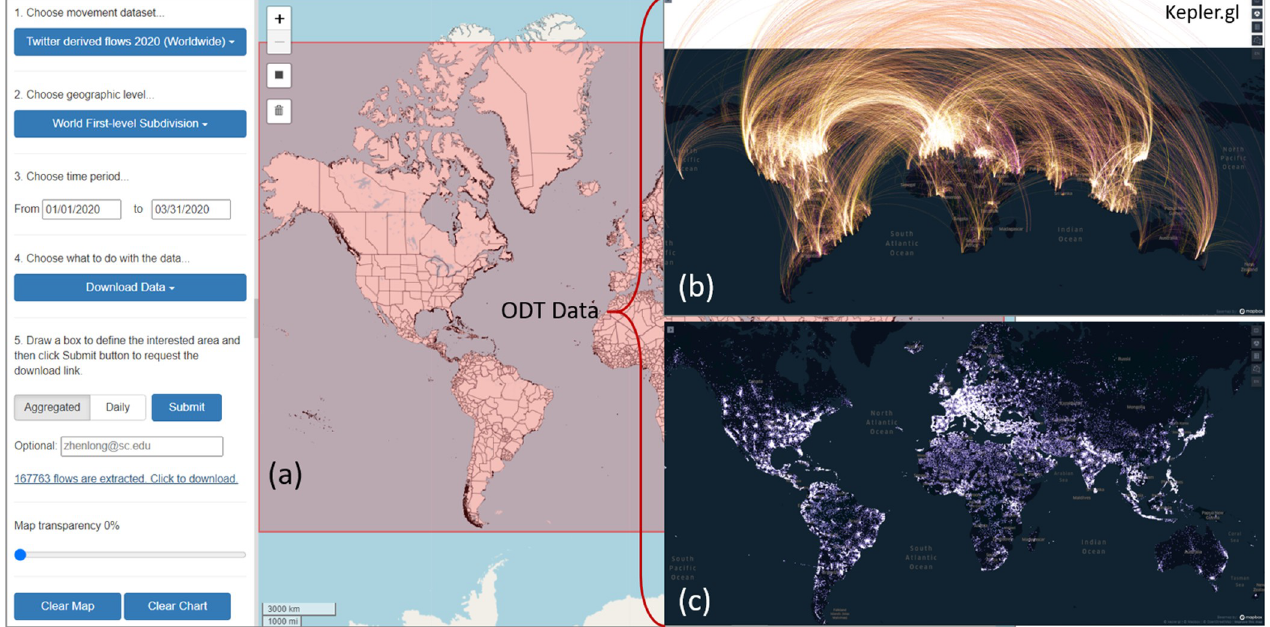
Fig 8. (a) Extract and download the Twitter-derived mobility data in ODT flow explorer at the world first-level subdivision from 01/01/2020 to 03/31/2020; (b) visualize the data in kepler.gl as a flow map; (c) visualize the origin locations as a point density map.